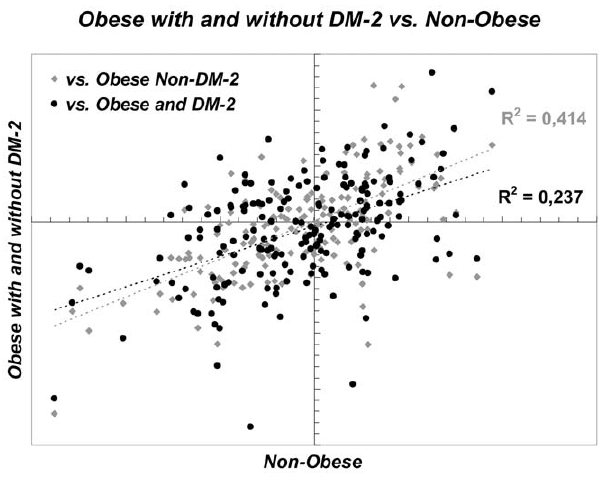
Figure 3. miRNAs expression profiling in human subcutaneous fat. Scatter plot showing comparison of miRNA expression profiles between subcutaneous fat from non-obese (n=6) and obese non-DM-2 (n=13, grey diamonds) or obese and DM-2 (n=9, black circles) women.